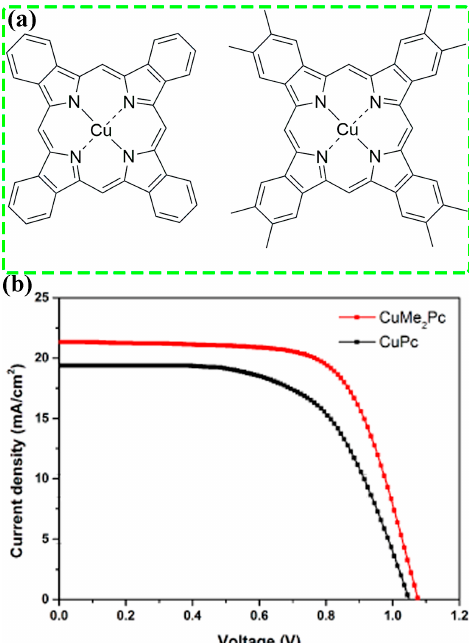
Figure 5. ( a ) Molecular structures of CuPc and CuMe 2 Pc. ( b ) J - V curves of PSCs based on CuPc and CuMe 2 Pc HTMs. Adapted with permission from Ref. [92]. Copyright 2017 Elsevier.